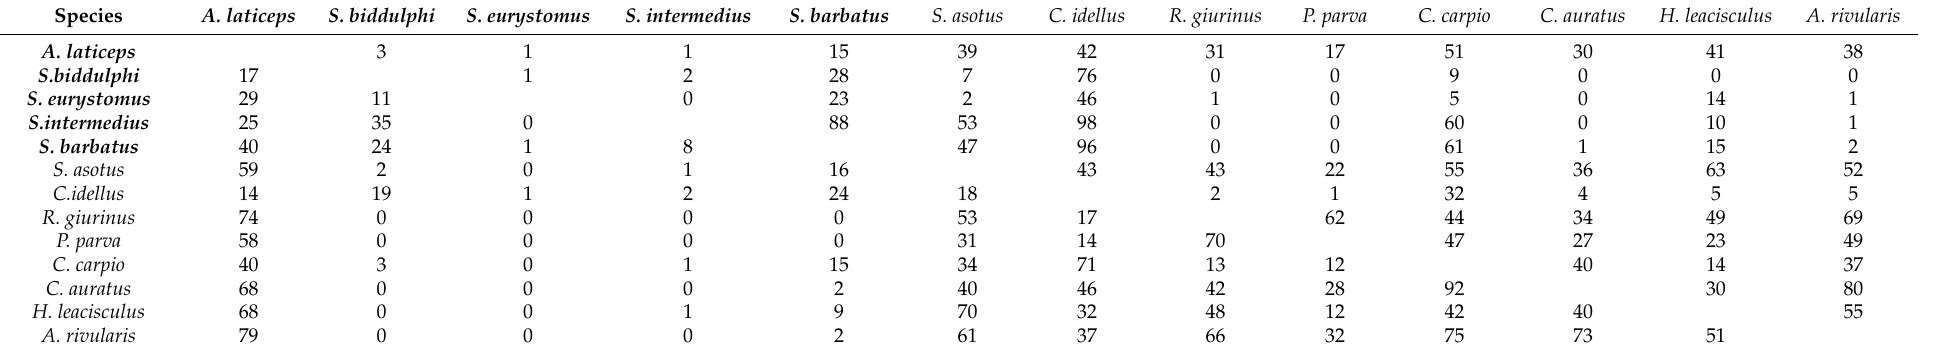
Table 3. The proportion (%) of SEAc overlap between fish species in the Kezil reservoir a